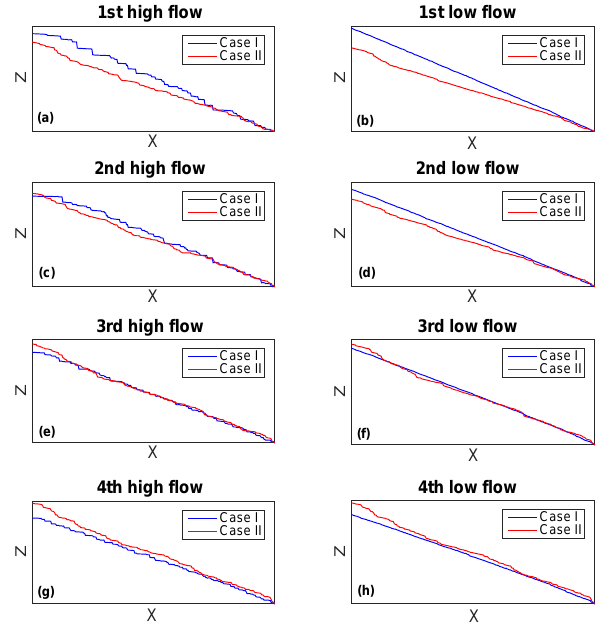
Figure 13. Unsteady simulations with four consecutive floods. Longitudinal profiles of bed elevation computed at the end of every high-flow period (left column: a, c, e, g ) and at the end of each of the following low-flow period (right column: b, d, f, h ) for a typical